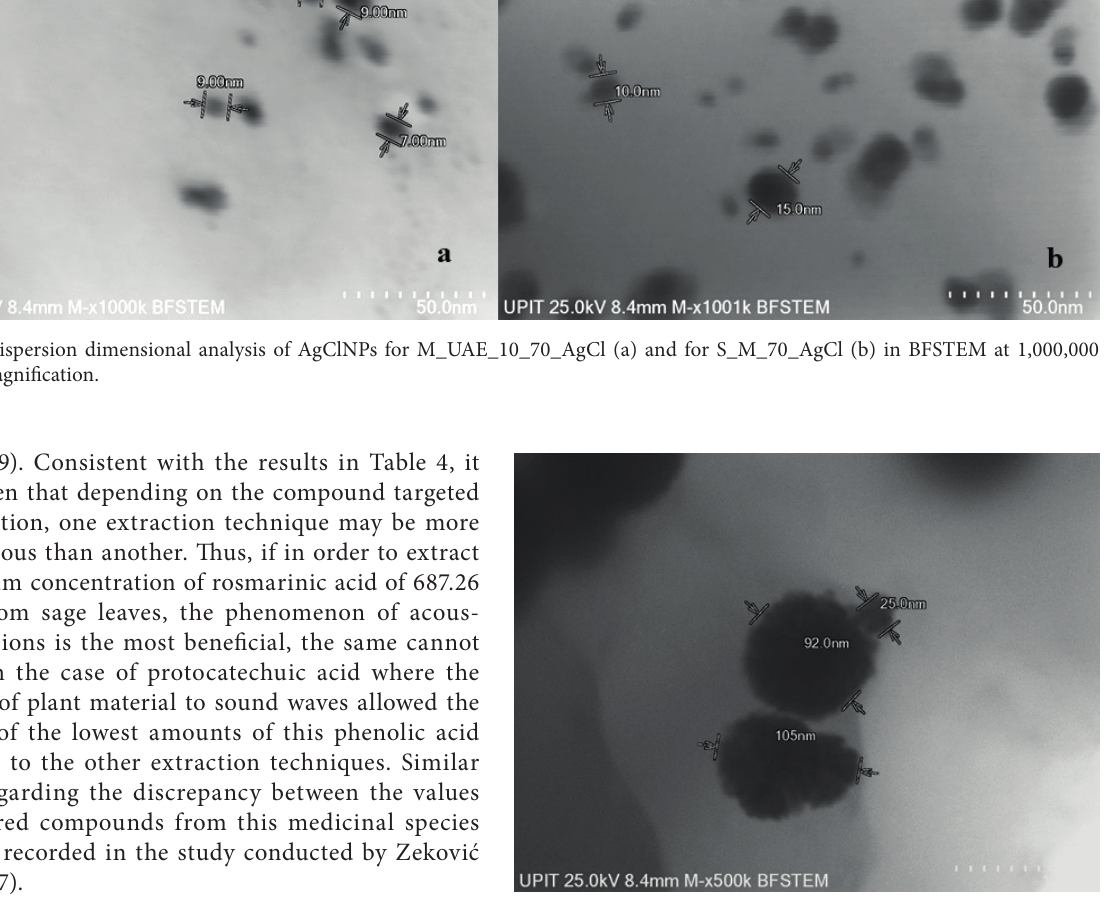
Figure 8. Dimensional analysis of AuNPs aggregates obtained in sage ethanolic